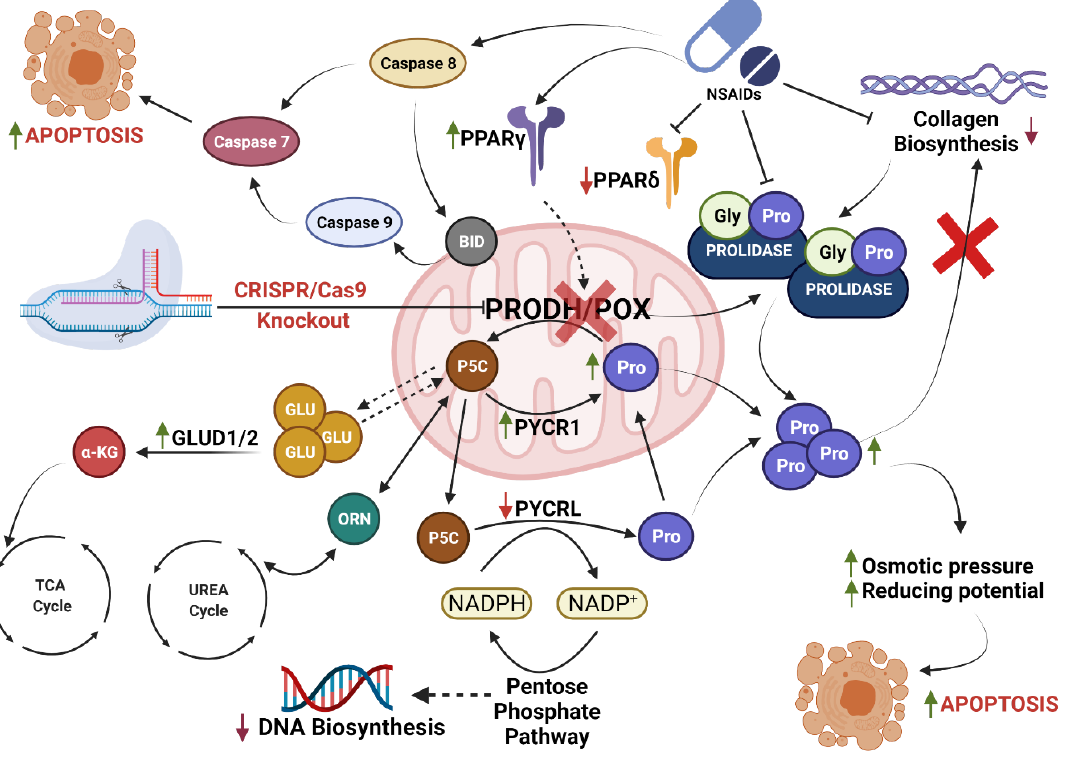
Figure 5. The mechanism of NSAID-induced apoptosis in MCF7 POX-KO cells. Created with BioRen- der.com, accessed on 28 January 2022, Agreement number: